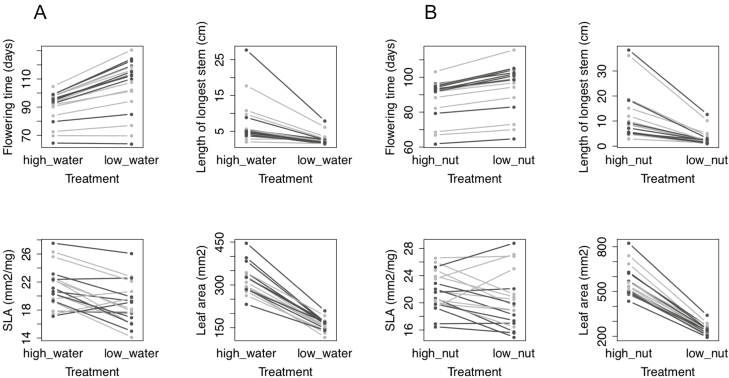
Reaction norms for Erodium cicutarium functional traits across treatments in a glasshouse experiment: (A) high- and low-water treatments; (B) high- and low-nutrient treatments. Populations from California are rendered in dark grey, and populations from Chile in light grey.